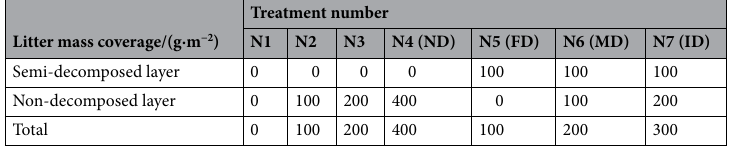
Table 2. The experimental design of this study. In this study, biomasses of the non-decomposed and semi- decomposed layers of litter were combined, and then divided into seven treatments (N1–N7). ND is non- decomposed state, ID is initial stage of litter decomposition, MD is middle stage of litter decomposition, FD is final stage of litter decomposition.